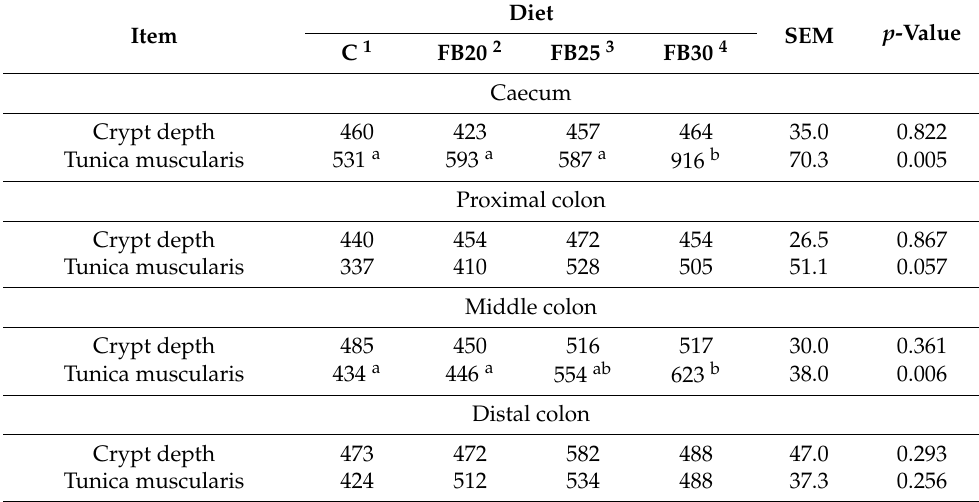
Table 3. Large intestine morphology of pigs fed diets with extruded faba bean seeds, µ